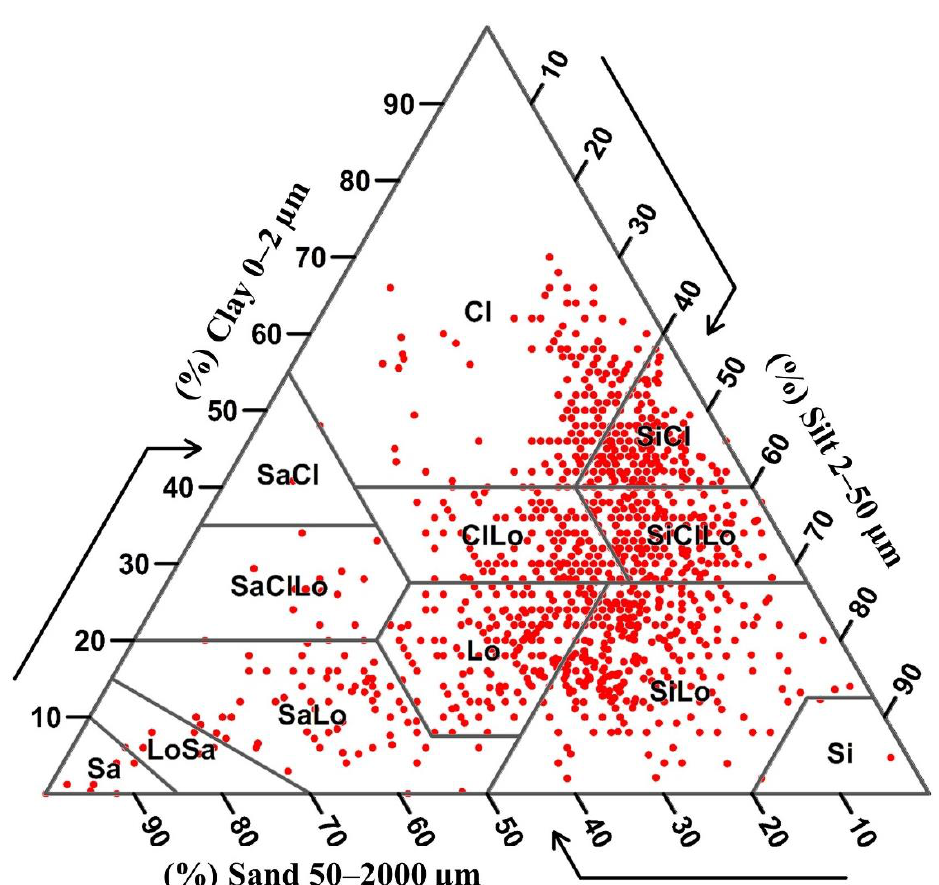
Figure 3. Distribution of soil texture classes for all samples based on the USDA soil texture triangle. (Cl: clay; SiCl: silty clay; SiClLo: silty clay loam; SaCl: sandy clay; SaClLo: sandy clay loam; ClLo: clay loam; Si: silt; SiLo: silt loam; Lo: loam; Sa: sand; LoSa: loamy sand; SaLo: sandy loam)